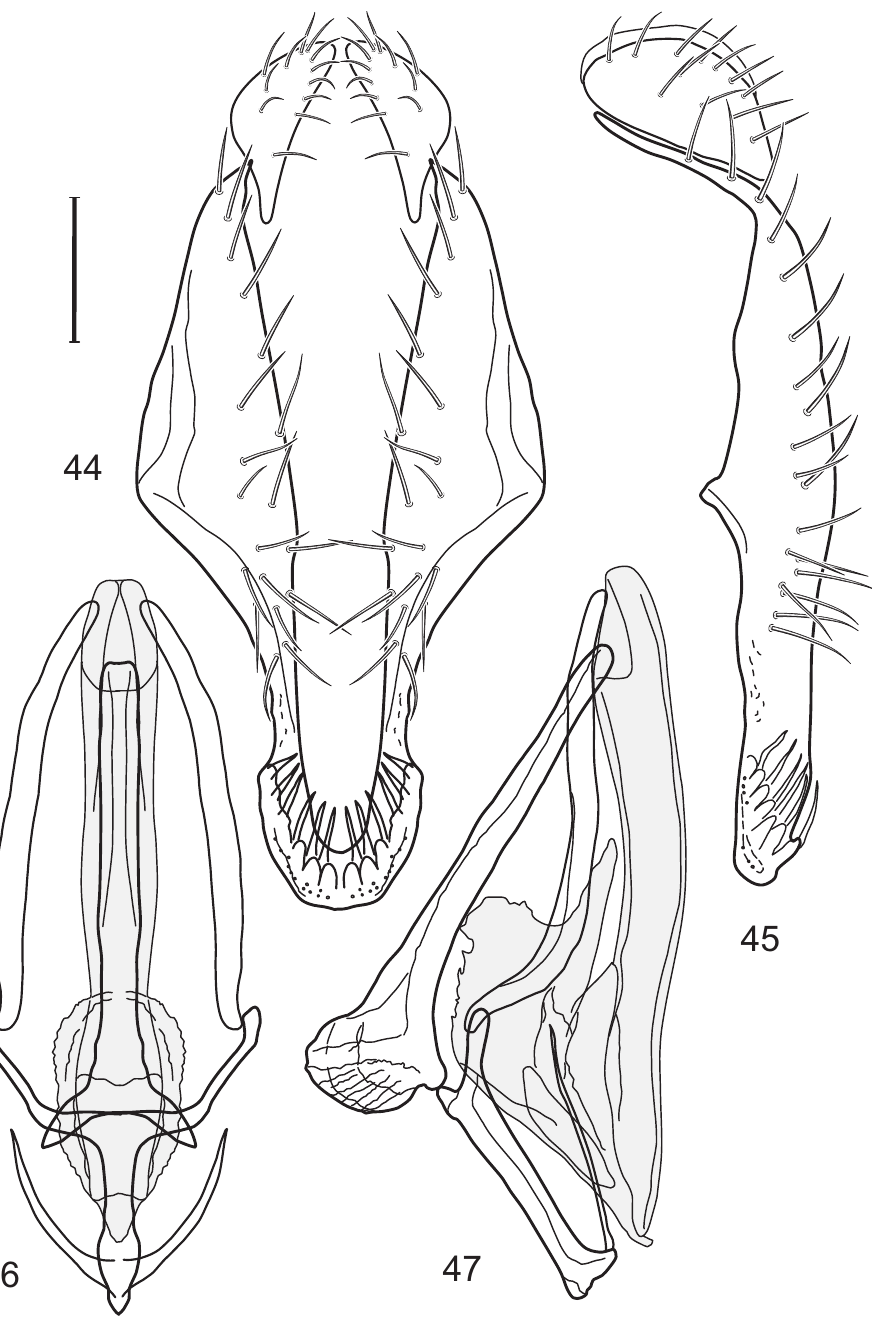
Figures 44–47. Hydrochasma spinosum sp. n. (Costa Rica. Puntarenas: Playa Jacó) 44 epandrium and cerci, posterior view 45 same, lateral view 46 internal structures of male terminalia (aedeagus [shaded], phallapodeme, gonite, hypandrium), ventral view 47 same, lateral view. Scale bar = 0.1